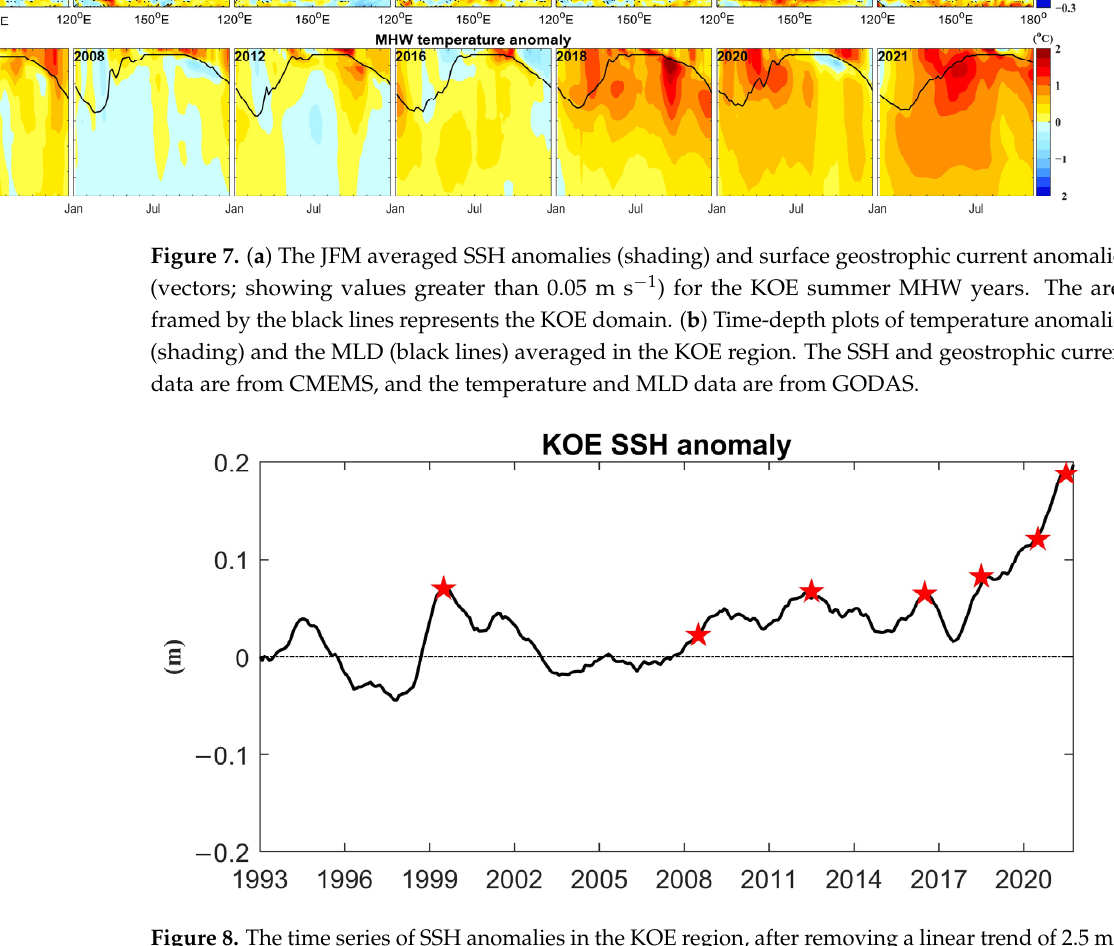
Figure 8. The time series of SSH anomalies in the KOE region, after removing a linear trend of 2.5 mm per year in the global ocean. The red stars indicate the seven strongest MHWs.